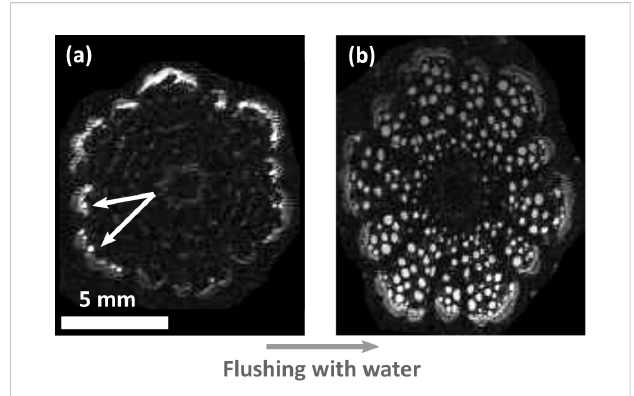
FIGURE 6 Magnetic resonance images of Clematis vitalba stem. (A) Living plant. The functional conductive xylem area is restricted to the outermost growth ring (white conduits, indicated by white arrows). Only a few active vessels were detected. (B) Flushed cross section. Conduits of all growth rings are water- fi lled after fl ushing. The images were equally contrasted by image analysis to highlight the functional